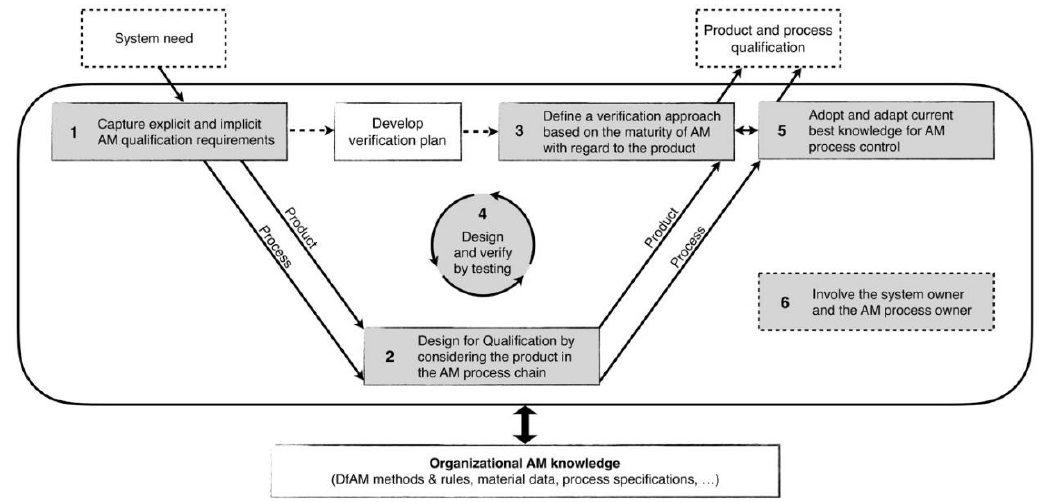
Figure 8. The Design for Qualification framework and the six design tactics. The framework is structured according the generic V model for verification, where each of the design tactics provide a direction for how to utilize the requirements capture, design and verify sequence in order to consider qualification aspects related to AM during product development, that is to Design for Qualification.